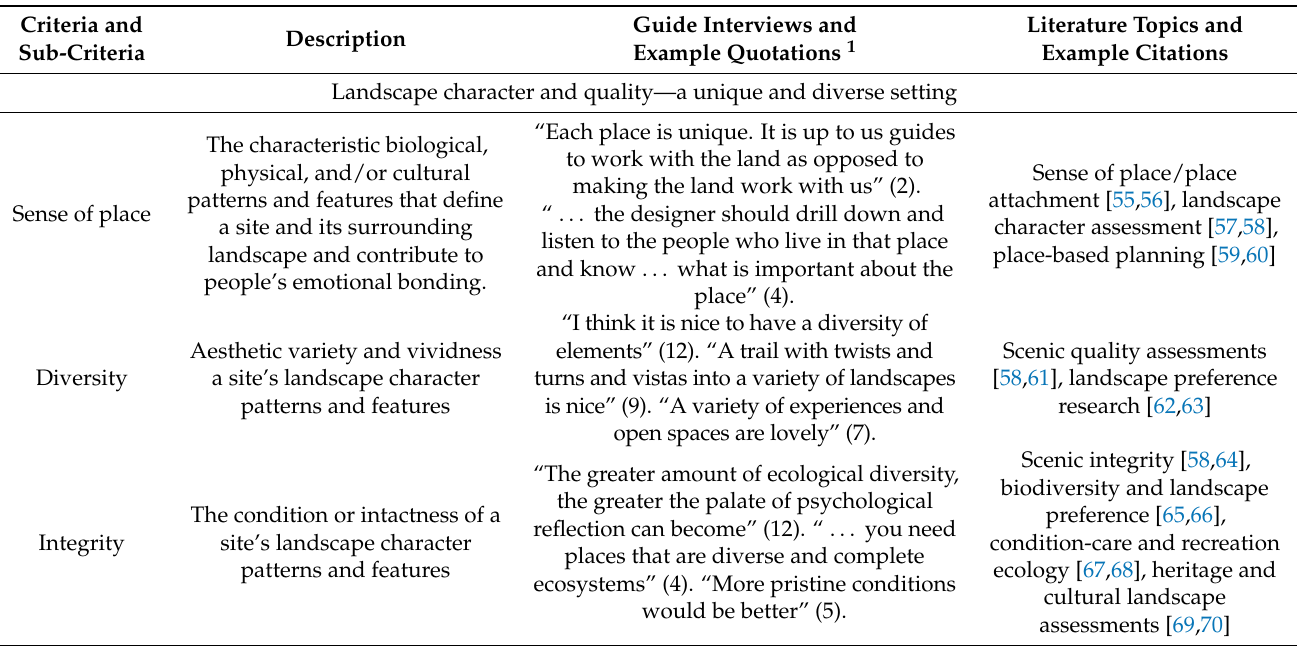
Figure 2. Conceptual structure of the key characteristics of forest therapy trails presented in this paper. Table 1. Site-related